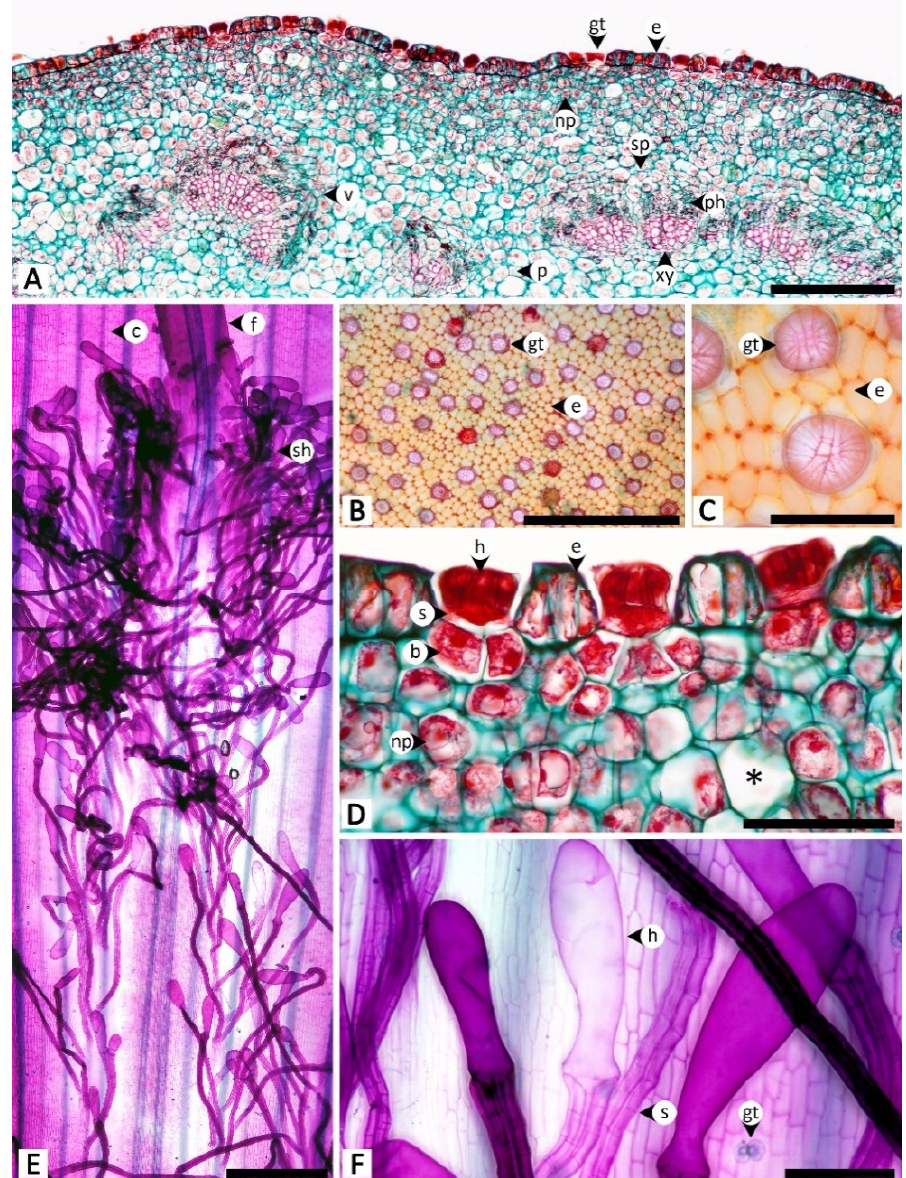
Figure 3. Micromorphology and anatomy of petiolar nectaries and staminal hairs of Rivea ornata via light microscopy. ( A ) Transversal view of petiole showing a petiolar nectary formed by epidermis, peltate glandular trichomes, nectariferous parenchyma, and subnectariferous parenchyma, as well as regions of petiole vascular tissues and cortex. ( B ) Surface of a petiolar nectary with peltate glandular trichomes distributed solitarily and evenly across the epidermis. ( C ) Close-up view of ( B ) showing details of the multicellular head of the peltate trichomes. ( D ) Close-up view of ( A ) along the epidermis showing details of the peltate trichomes, epidermal cells, nectariferous parenchyma, and a cell used to store druse crystals (asterisk). ( E ) The base of a stamen where it connects to the corolla tube covered in staminal hairs. ( F ) Details of staminal hairs showing apical glands and stalks. Abbreviations: b, base; c, corolla; e, epidermal cell; f, filament; gt, glandular trichome; h, head; np, nectariferous parenchyma; p, parenchyma; ph, phloem; s, stalk; sh, staminal hair; sp, subnectariferous parenchyma; v, vascular tissue; xy, xylem. Scale bars: ( A , E ) 1000 µ m; ( B ) 500 µ m; ( C , D ) 100 µ m; ( F ) 200 µ